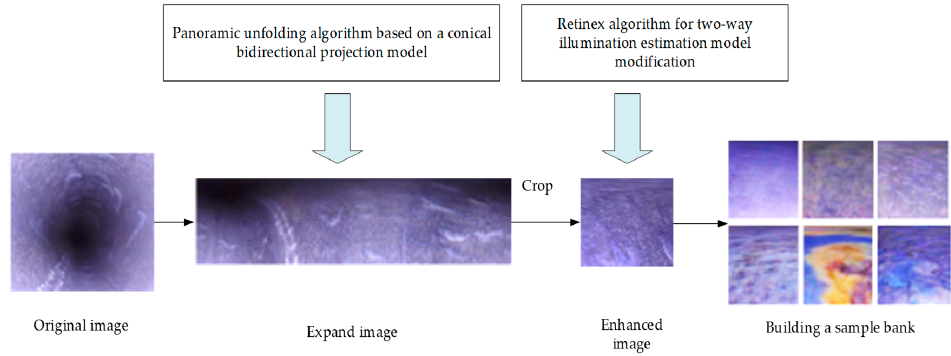
Figure 5. Image pre-processing process diagram.